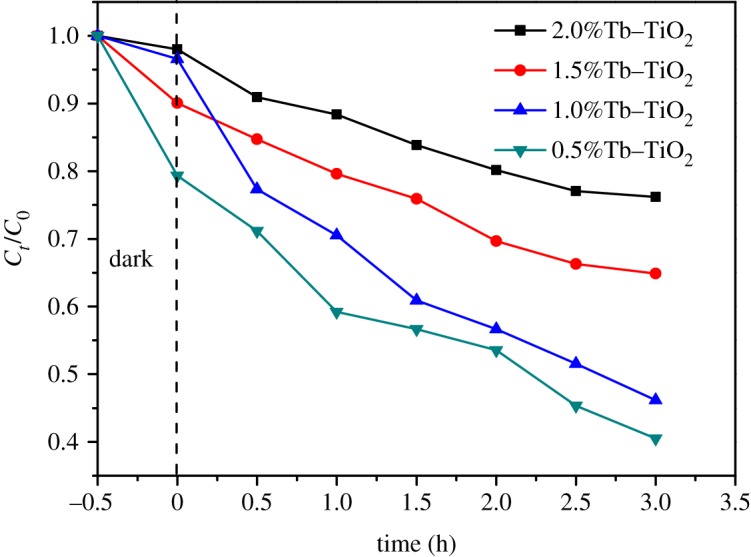
Effect of Tb doping amount on photocatalytic activity (10 mg l−1 MB, 1.0 g l−1 Tb–TiO2 dose, T = 298 K).